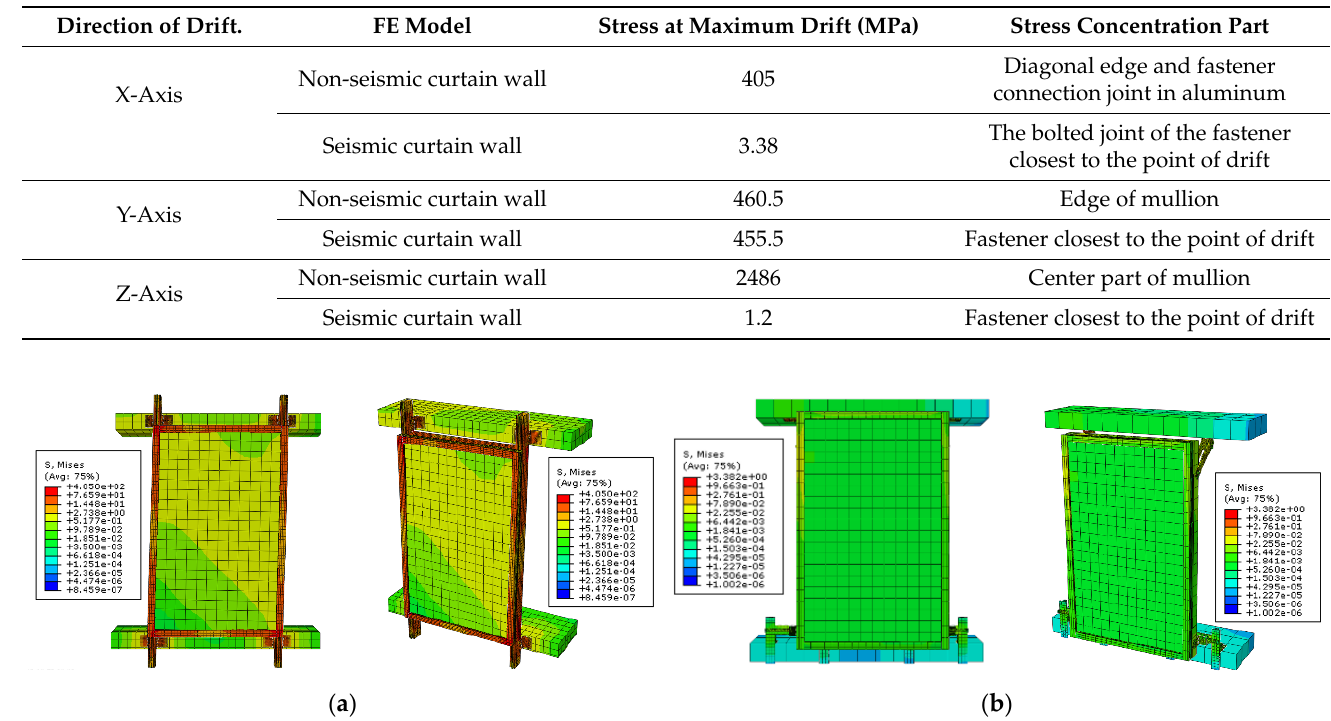
Figure 28. Comparison of appearance changes under applied Z -axis inter-story drift: ( a ) non-seismic curtain wall module; ( b ) seismic curtain wall module. Table 10 shows the maximum stress generated in each member. According to the FE analysis results, it was found that the stress distribution in each member was greatest in the mullion when the dynamic drift was applied. When dynamic drift was applied, the displacement could be controlled because the moving clip of the linear guide moves along the rail in the axial direction in which the drift is applied. Based on this principle, the stress applied to the exterior material is absorbed and dissipated.